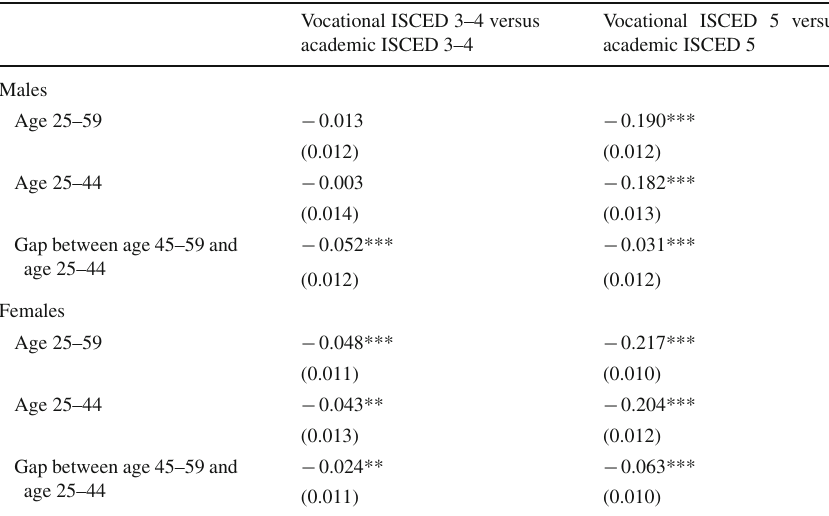
Table 6 Average treatment effects of vocational education relative to academic education. Dependent variable: log hourly earnings. Source : Calculations based on PIAAC data Vocational ISCED 3–4 versus Vocational ISCED 5 versus academic ISCED 3–4 academic ISCED